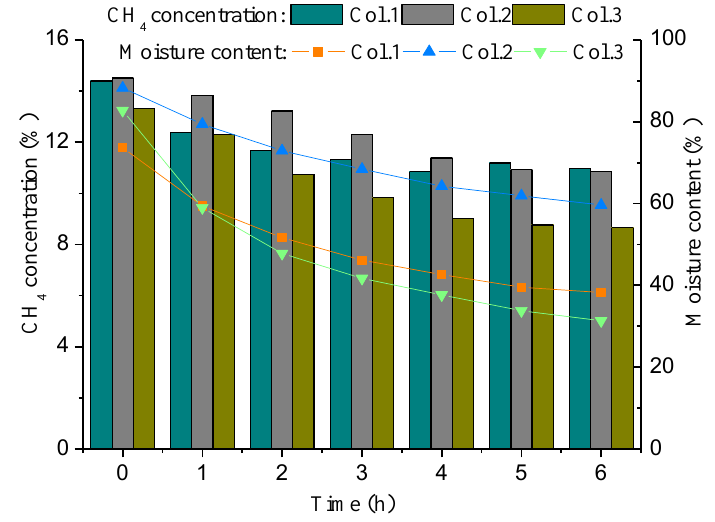
Figure 6. CH 4 concentration changes over the moisture content in columns.